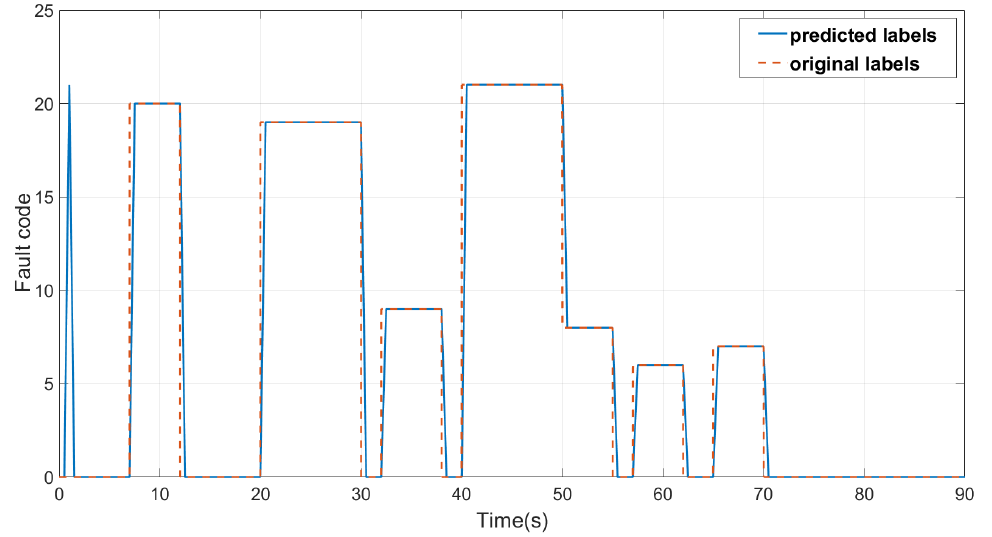
Figure 19. An example of the result of fault diagnosis for PMSM, which has eight fault states (Blue line: the predicted label with CNN model, red line: the original fault label): non-fault (0), SSF in the inverter of the right motor (20), OSF in the inverter of the right motor (19), complete demagnetization of the rotor in the left motor (9), phase-to-phase short circuit in the right motor (21), phase-to-phase short circuit in the left motor (8), SSF in the inverter of the left motor (7), OSF in the inverter of the left motor